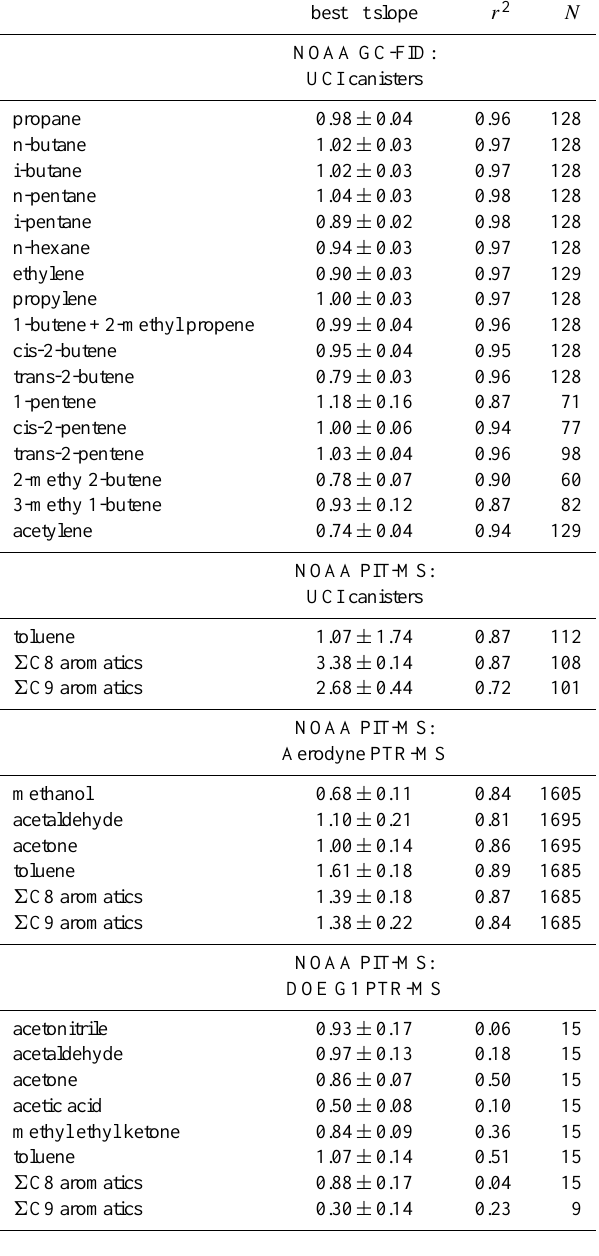
Table 2. Slopes resulting from ODR regression of scatter plots be- tween VOCs measured by 2 or more techniques during MILAGRO. Also shown here are 1 σ uncertainties in slopes, correlation (r 2 ) co- efficients, and the number of points compared (N)